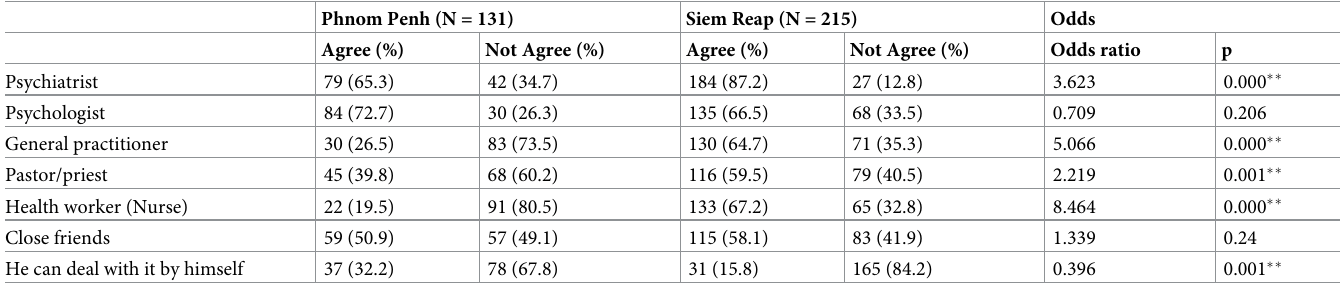
Table 4. Participants’ help-seeking recommendations.